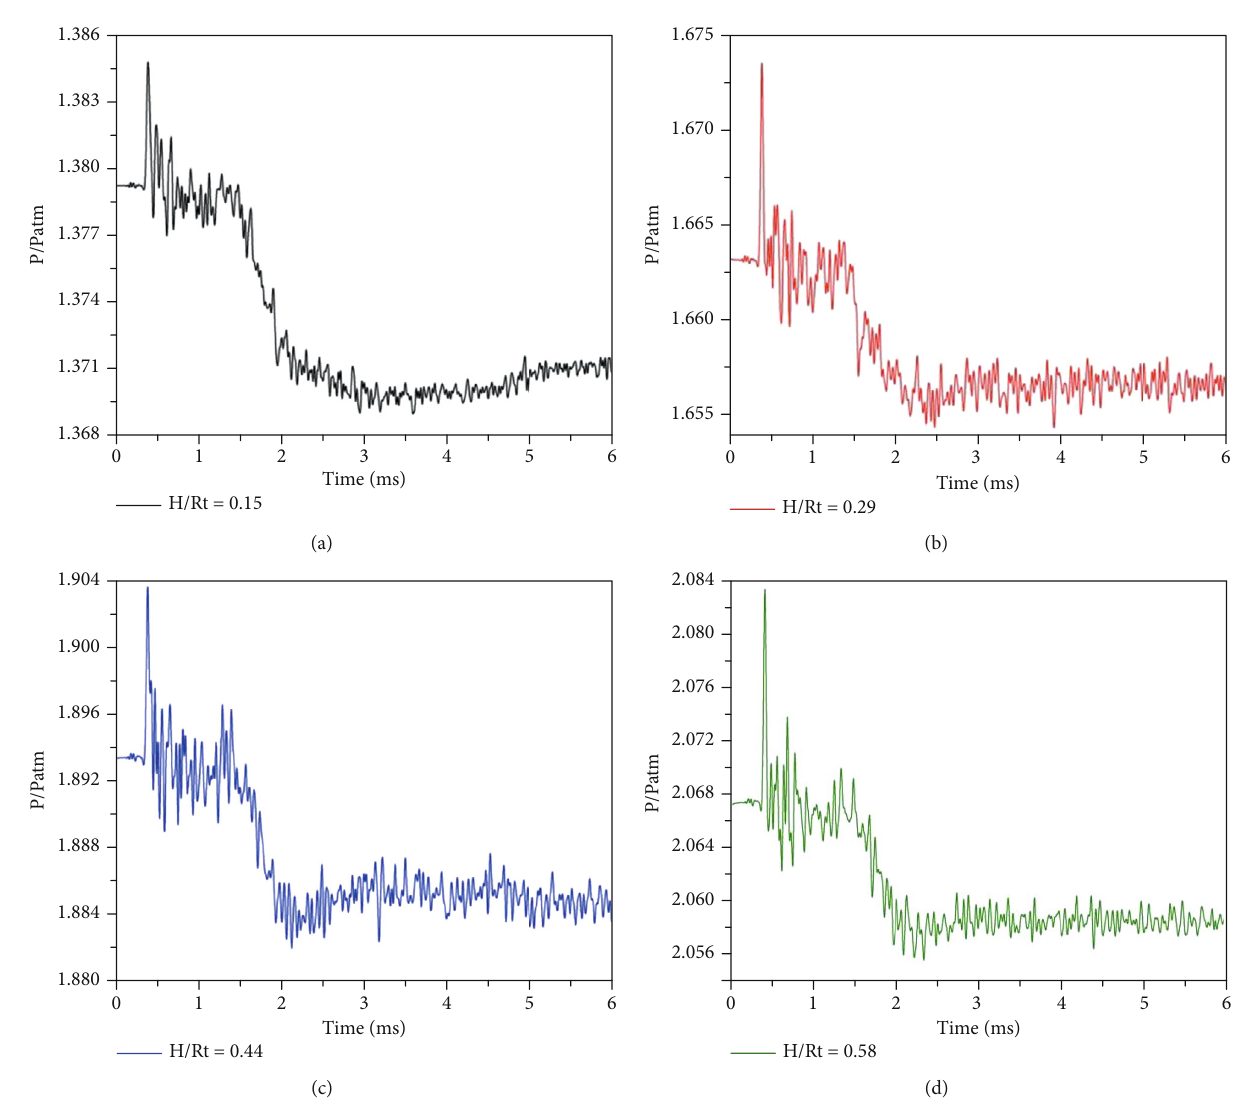
Figure 17: Pressure oscillations at the measurement point for di ff erent rod penetration heights ( NPR = 4 : 6 and X = 0 : 29 ; (c) H / R (b) H / R t